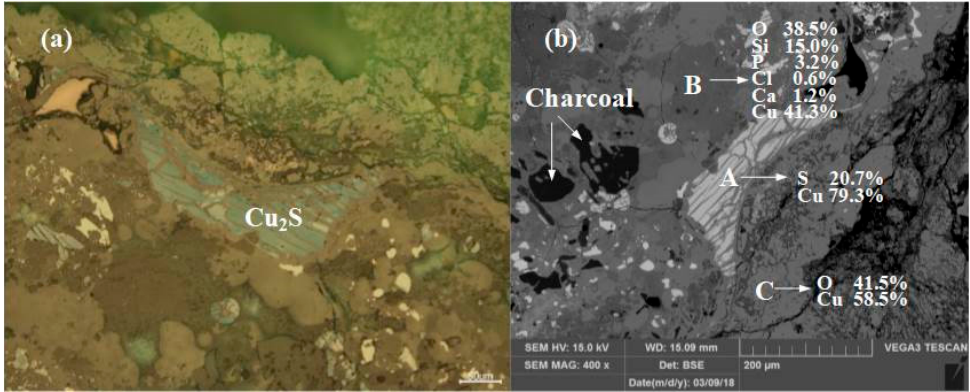
Figure 5. Optical micrograph ( a ) and SEM backscattered electron image ( b ) of YBD01.